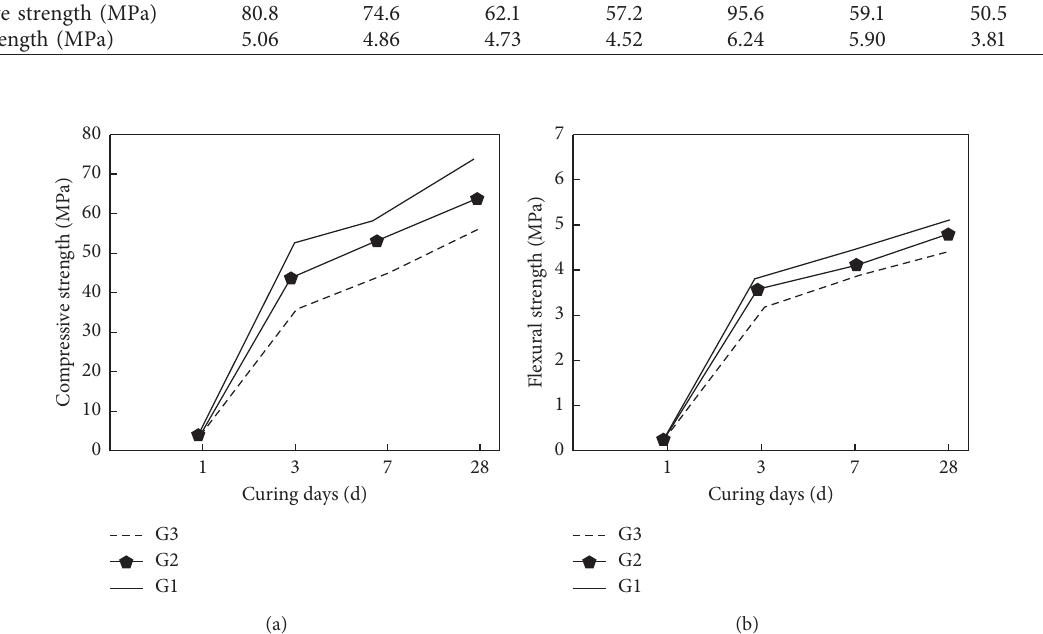
Figure 2: Effects of powder activator on compressive strength and flexural strength of coal gangue-based geopolymeric concrete. (a) Effects on compressive strength. (b) Effects on flexural strength.